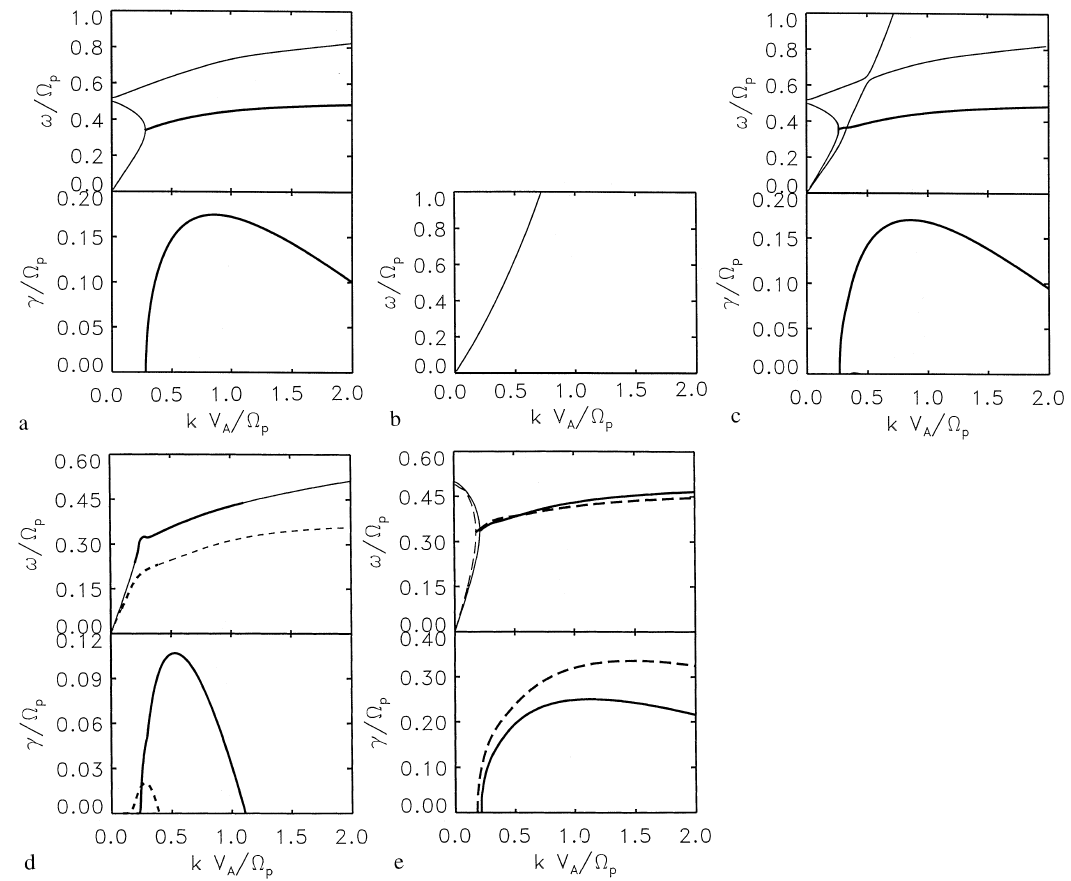
betas; the solid lines represent (cid:98) (cid:136) 0 : 1 ; the dashed lines represent 0 k (cid:98) (cid:136) 1 : 0; the fat lines mark the unstable regions; only branches with 0 k instability are drawn. e Dispersion ( upper panel ) and growth rate ( lower panel ) of coupled L-R modes at higher abundance of the nongyrotropic species; the solid lines represent n 0 (cid:136) 0 : 05 n p ; the dashed lines represent n 0 (cid:136) 0 : 1 n p ; the fat lines mark the unstable regions; completely stable branches